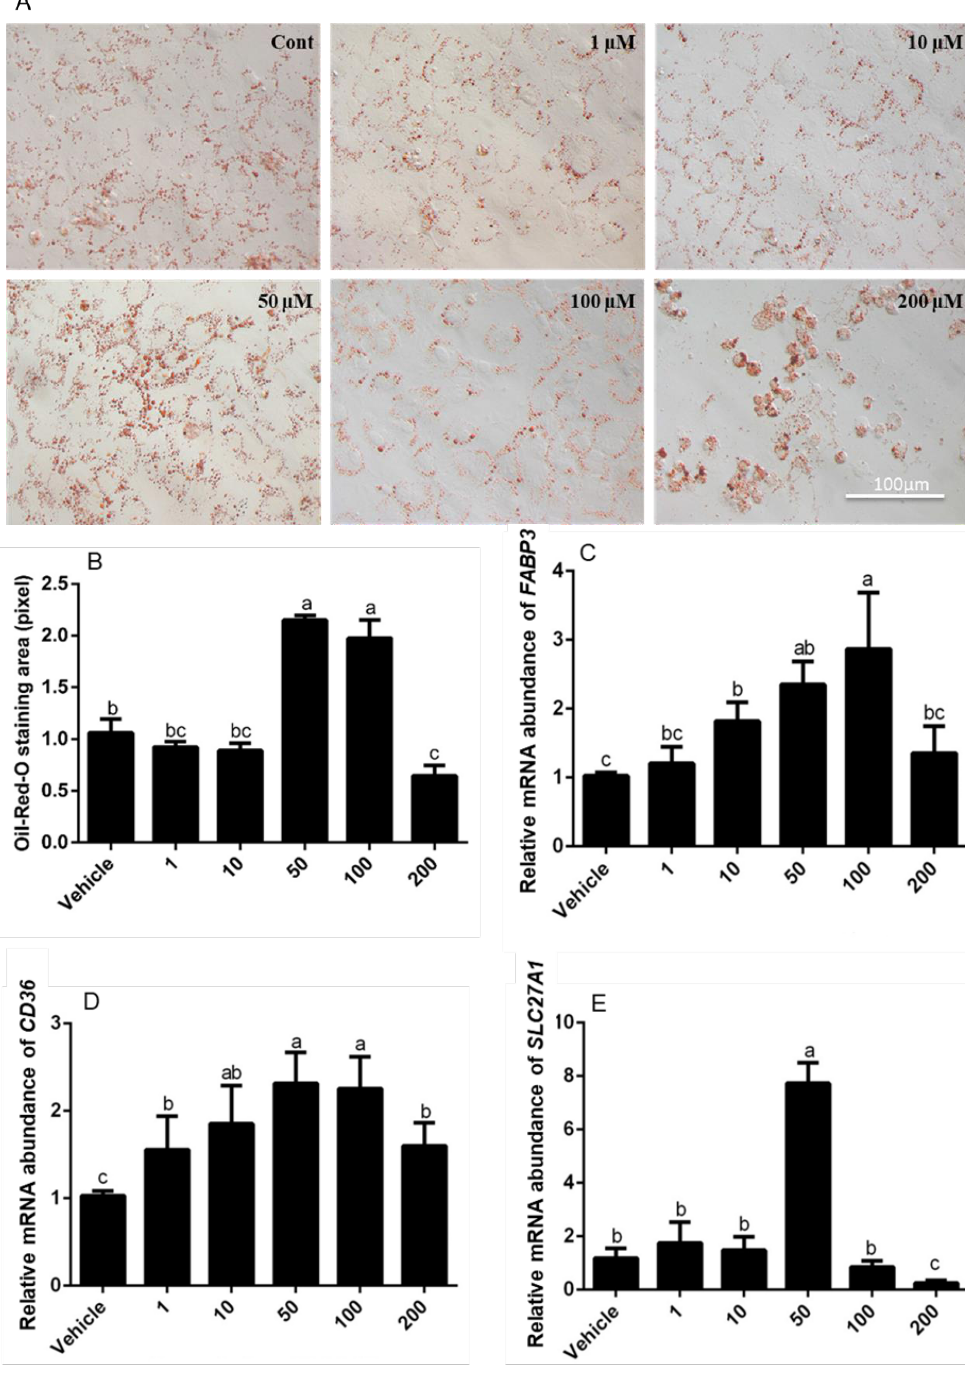
Figure 3. Effects of AA on the lipid droplet formation in granulosa cells. Cells were incubated with the doses given of AA for 24 h. Oil-Red-O staining was conducted as described in the methods section and red staining is indicative of lipid droplets in cultured granulosa cells with the doses given of AA for 24 h ( A ). Qualification of lipid droplets by ORO (Oil-Red-O) analysis in granulosa cells ( B ). FABP3 ( C ), CD36 ( D ) and SLC27A1 ( E ) mRNA abundance was determined in granulosa cells. Data are means ± SEM. of three independent replicates. For each treatment, means without common letters are significantly different ( p < 0.05).